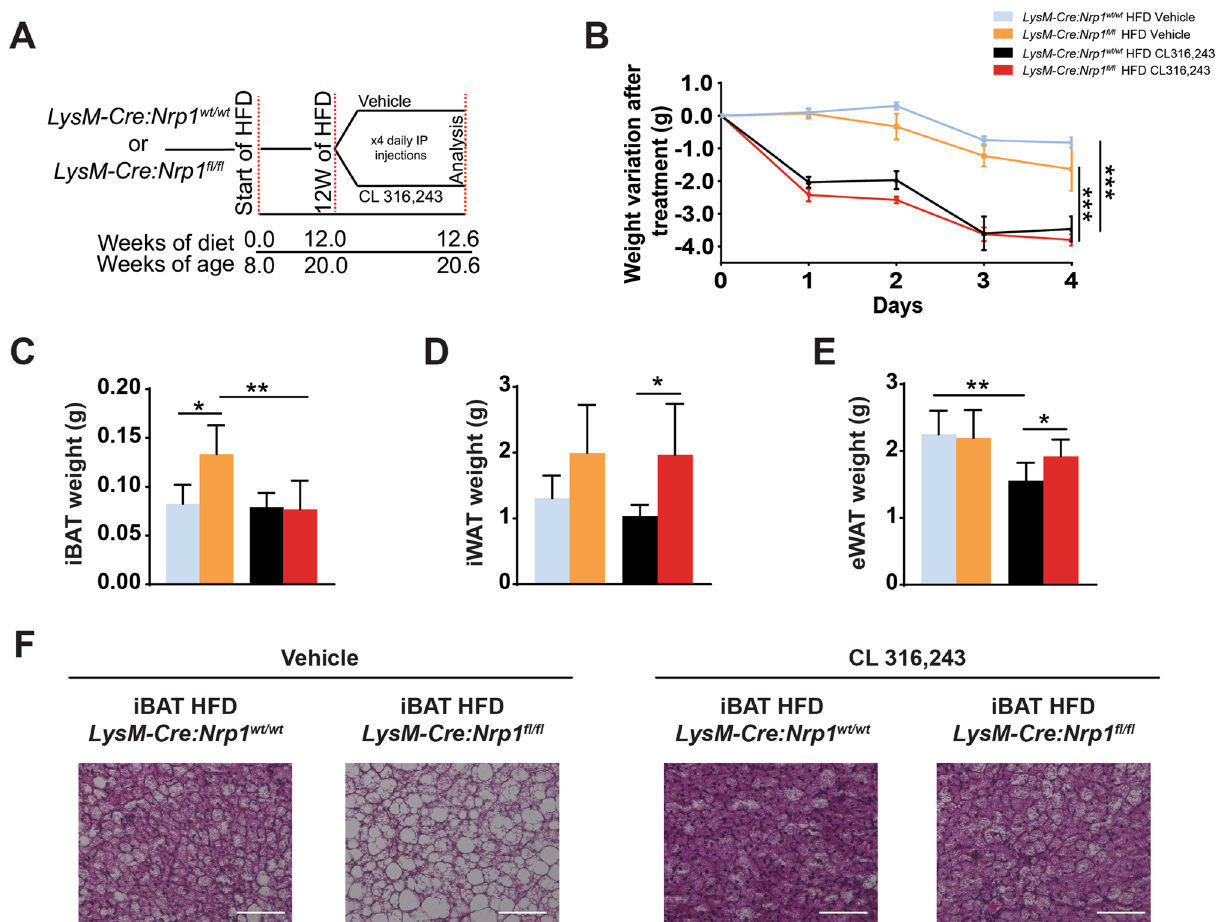
Figure 4. Nonshivering thermogenic stimulation reverses iBAT hyperthrophy in LysM-Cre:Nrp1 fl/fl mice. ( A ) Schematic representation of the experimental design. At 8 weeks of age, mice were fed with a high-fat diet (HFD) up to 12 weeks. At 12 weeks of diet, mice were injected i.p. once daily with CL316,243 or vehicle during 4 consecutive days. ( B ) Weight variation of LysM-Cre:Nrp1 fl/fl and LysM-Cre:Nrp1 wt/wt mice treated with CL316,243 or vehicle (n = 3–4). ( C ) iBAT, ( D ) iWAT and ( E ) eWAT masses after CL316,243 or vehicle treatment (n = 5–7). ( F ) Representative H&E staining of iBAT from LysM-Cre:Nrp1 wt/wt and LysM-Cre:Nrp1 fl/fl mice treated with CL316,243 or vehicle, n = 4 mice per genotype. Data are presented as mean ± SEM. * p < 0.05; ** p < 0.01; *** p <